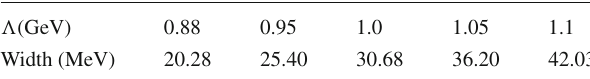
Table 2 The decay rate of X ( 5568 ) → B s π + ( β = 0 . 5329 GeV) (cid:9) (GeV)